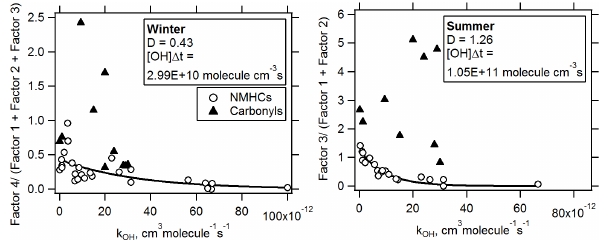
Fig. 6. Relationships between the ratios of VOCs abundances in the aged emissions factors with those in fresh emission factors and k OH values for each VOC species. Each data point represents one compound. The lines are the fitted results from Eq.